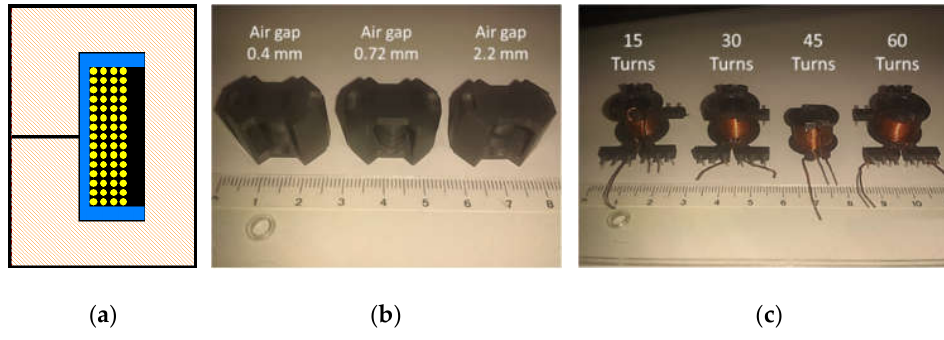
Figure 9. ( a ) Axisymmetric representation of the considered inductors. Representation of a 60 AWG24 turn inductor in an RM8/I core (15 turns per layer); ( b ) RM8/I-3F3 cores with air gaps of 0.4 mm, 0.72 mm, and 2.2 mm (from left to right); ( c ) windings of 15 to 60 turns (1 to 4 layers) with AWG24 round wire.